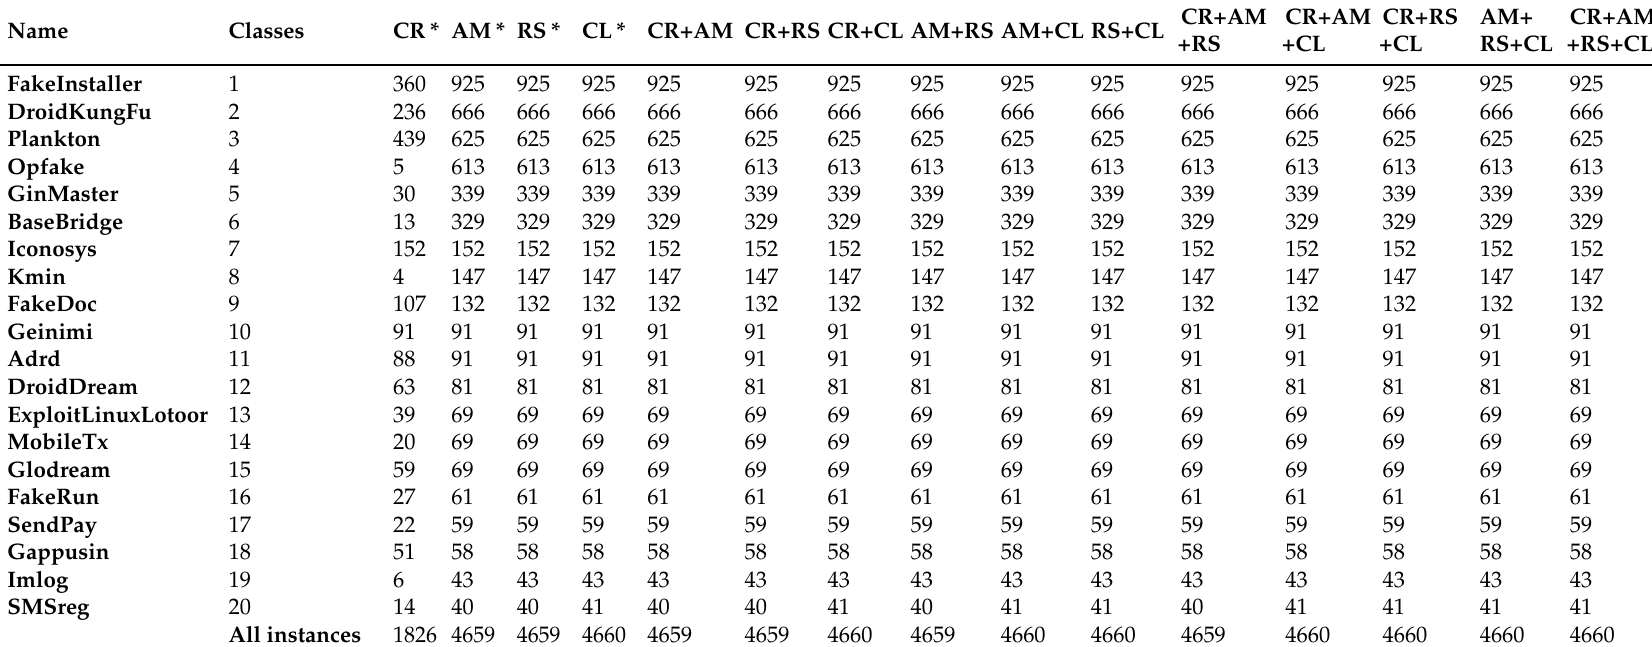
Table 2. The combinations and associated instances of each malware class from DREBIN